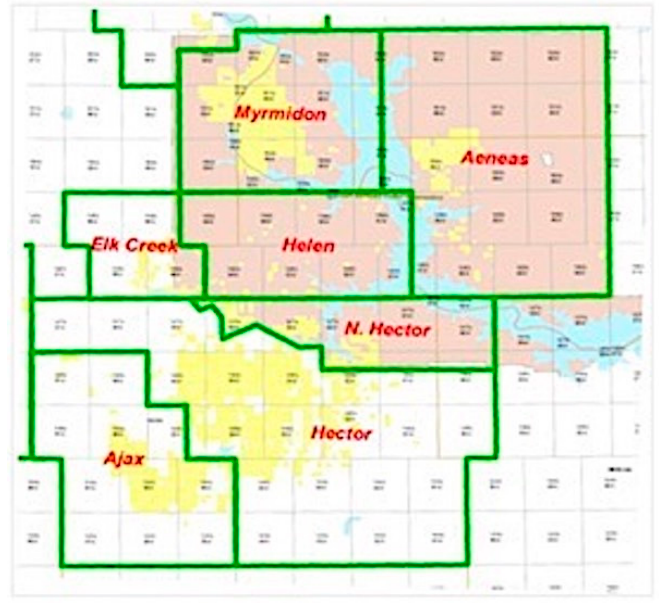
Figure 3. Location of Hector field where wells for this study are located [17] .